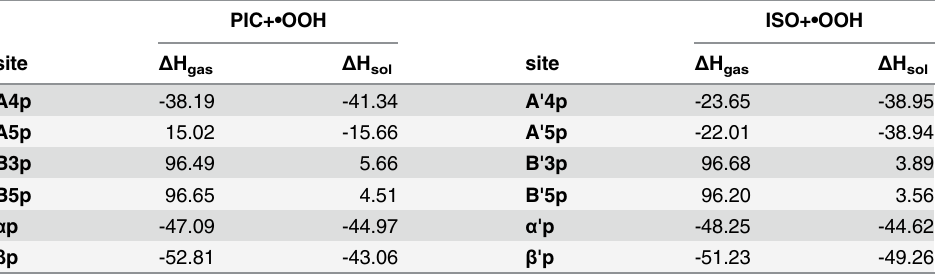
Table 5. The reaction enthalpies at 298K for reactions of PIC and ISO with (cid:129) OOH in the gas phase and water (in kJ/mol). PIC+ (cid:129) OOH ISO+ (cid:129) OOH